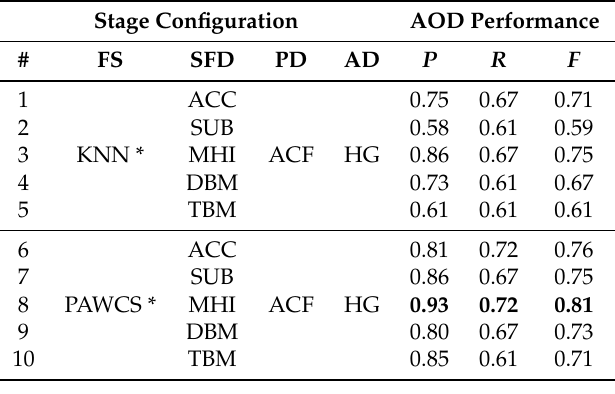
Table 7. Results comparing stationary foreground segmentation approaches for AOD performance. Bold indicates the best results. Key: FS = Foreground Segmentation. SFD = Stationary Foreground Detection. PD = Pedestrian Detection. AD = Abandoned Discrimination. P = Precision. R = Recall. F = F-score.